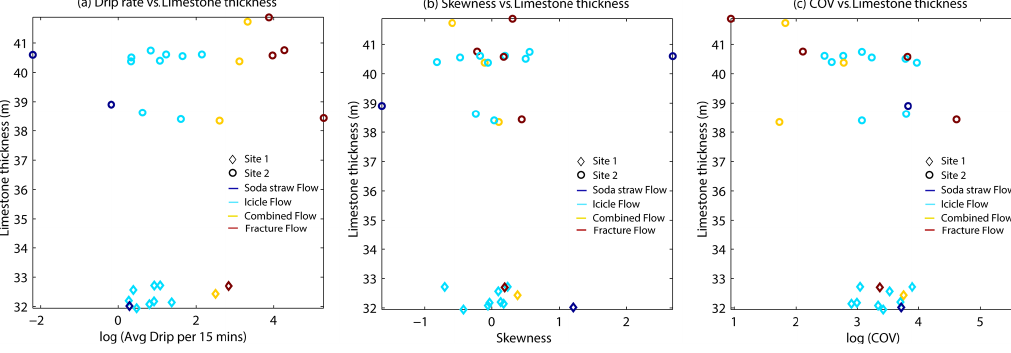
Figure 8. Drip data characteristics for different flow